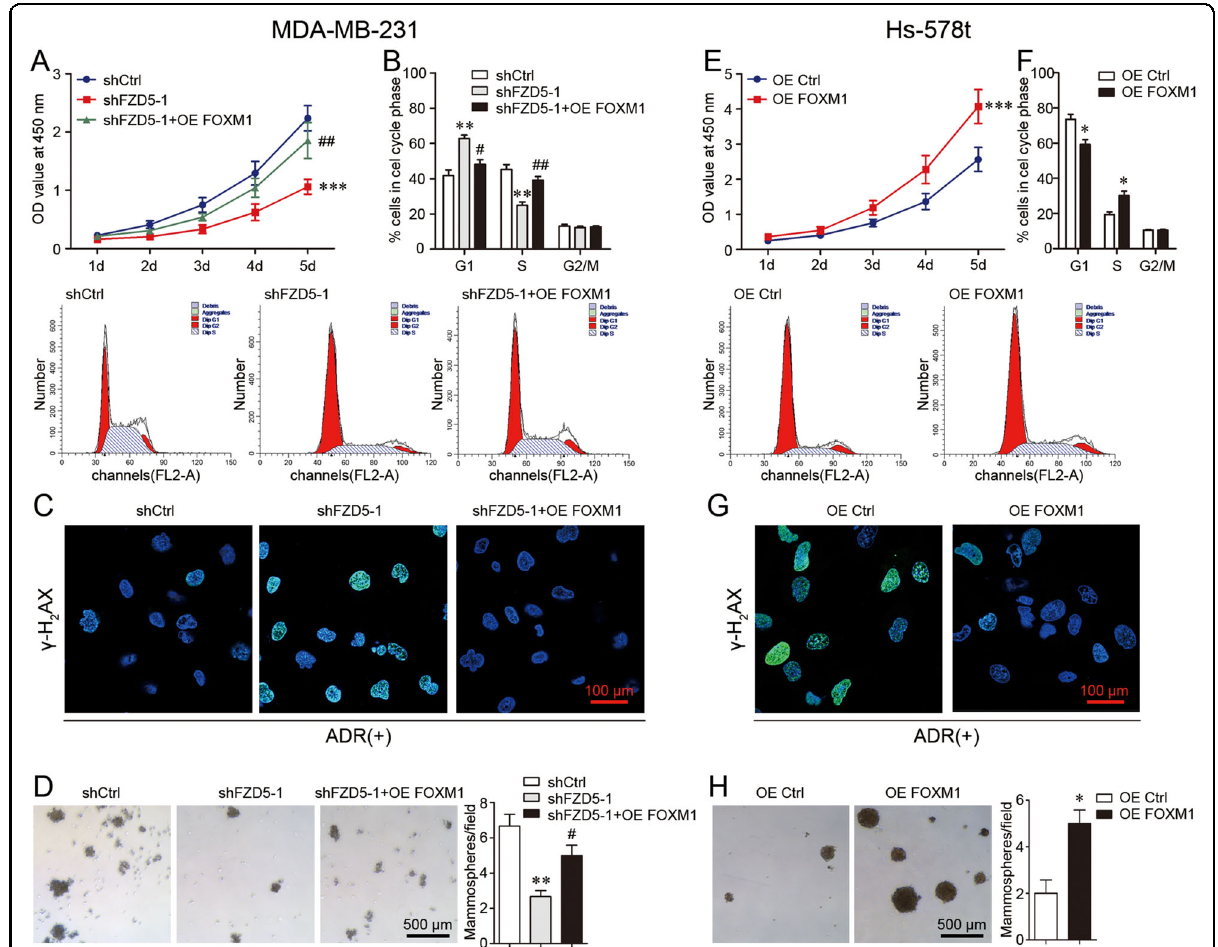
Fig. 7 FOXM1 overexpression induces FZD5-associated phenotype. A Viability of MDA-MB-231 cells was detected by CCK8. B Cell cycle of MDA- MB-231 cells was analyzed by fl ow cytometry. C γ -H2AX expression in MDA-MB-231 cells was detected by immuno fl uorescence 48 h after treatment with ADR (300 nM). Scale bar: 100 μ m. D Mammosphere formation of MDA-MB-231 cells was shown. Scale bar: 500 μ m, mean ± SD, n = 3. ** P < 0.01, *** P < 0.001, vs. shCtrl; # P < 0.05, ## P < 0.01, vs. shFZD5-1. E Viability of Hs-578t cells was detected by CCK8. F Cell cycle of Hs-578t cells was analyzed by fl ow cytometry. G γ -H2AX expression in Hs-578t cells was detected by immuno fl uorescence 48 h after treatment with ADR (300 nM). Scale